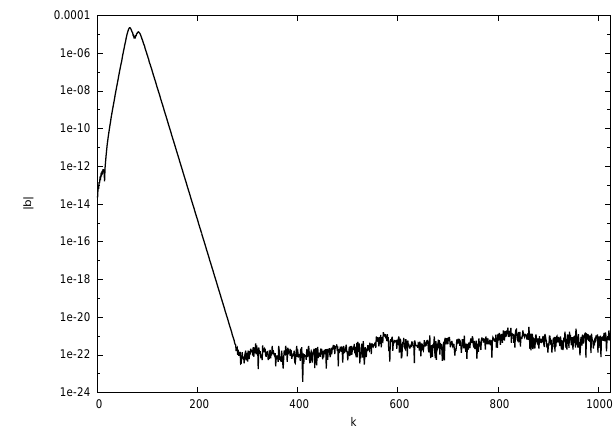
Figure 7. Fourier spectrum | b k | at the moment of first collision.